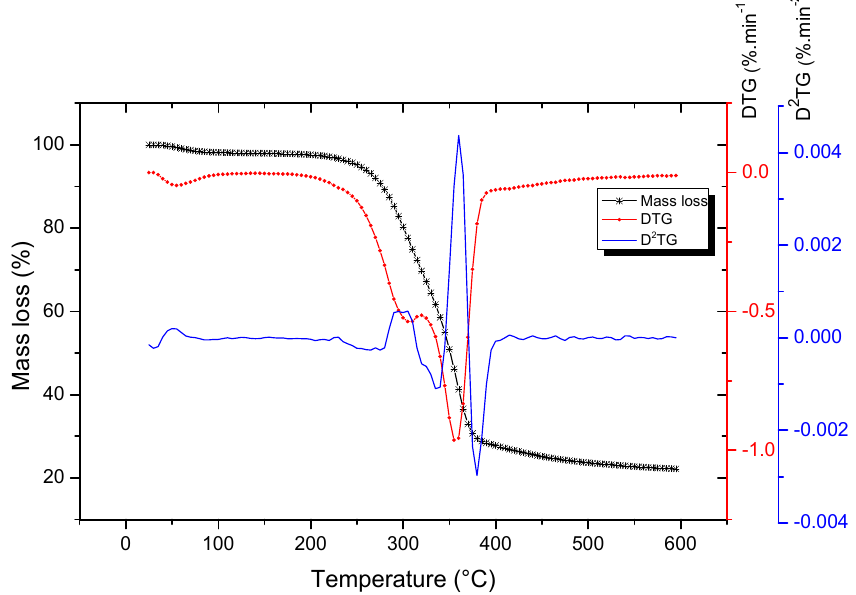
Figure 2. Thermogravimetric curve (TG), its derivative (DTG), and second-order derivative (D 2 TG) for sugarcane bagasse biomass under N 2 atmosphere and heating rate 10 °C min − 1 .